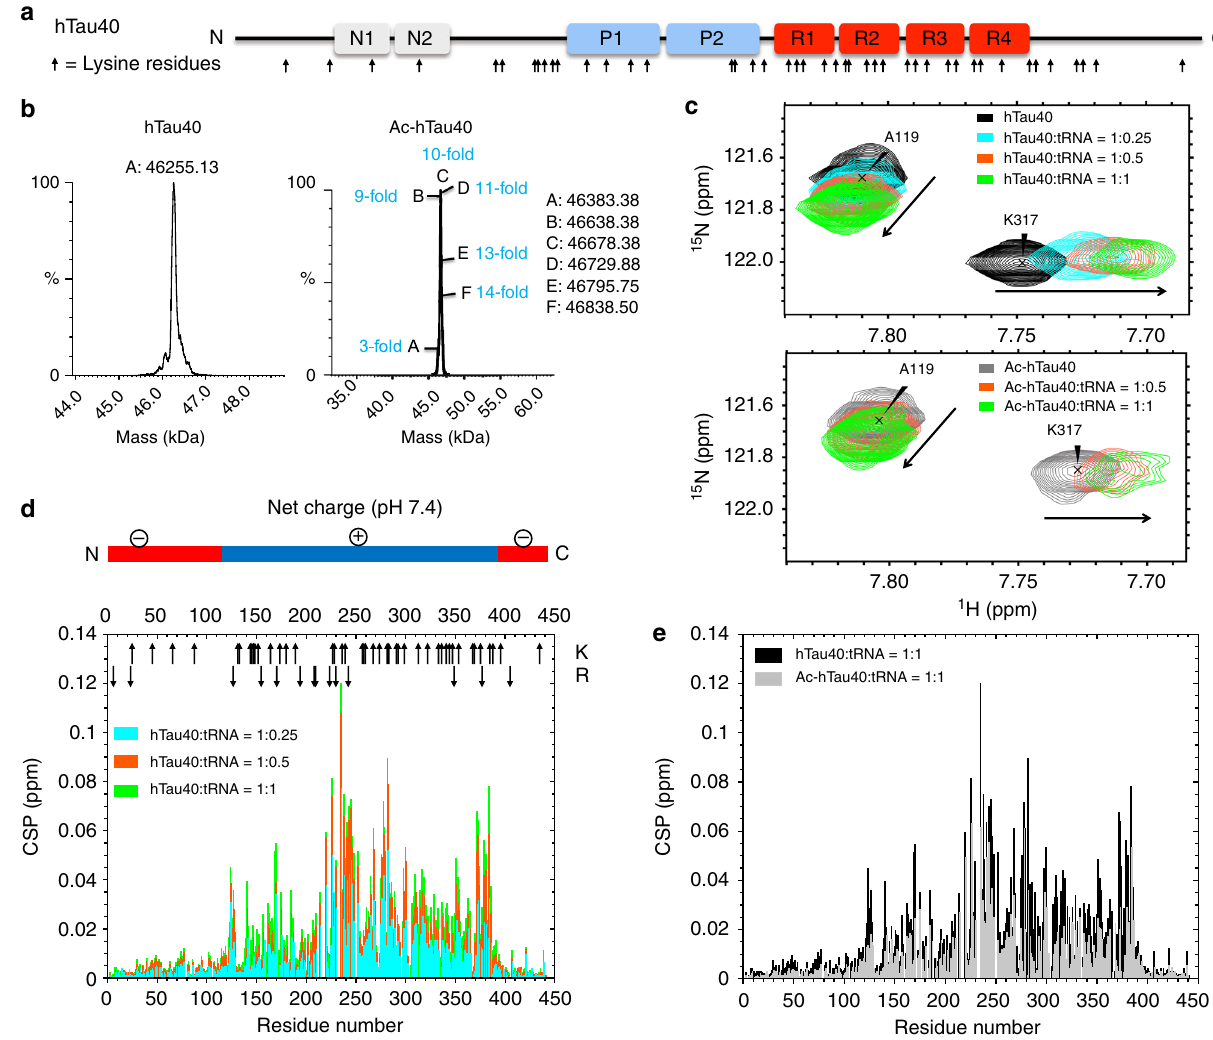
Fig. 7 Acetylation weakens binding of tau to RNA. a Domain organization of hTau40. The location of its 44 lysine residues is marked by arrows. b Mass spectra of 15 N-labeled hTau40 (left) and 15 N-labeled hTau40 acetylated by CREB (right). Identi fi ed masses (in Da) are indicated. Tau is acetylated at up to 14 sites. c Superposition of selected regions of 2D 1 H- 15 N spectra of hTau40 (top, black) and acetylated hTau40 (bottom, gray), respectively, for increasing molar ratios of tRNA: 0.25 (cyan), 0.5 (orange) and 1 (green). d Averaged 1 H, 15 N chemical shift perturbations (CSP) of resonances in 2D 1 H- 15 N HSQC spectra of hTau40 caused by binding to tRNA (color code as in c ). The net charge of different domains of hTau40 is illustrated on top. Arrows mark lysine and arginine residues. e CSP of resonances in 2D 1 H- 15 N HSQC of hTau40 (black) and acetylated hTau40 (gray) caused by the addition of an equimolar concentration of tRNA (see also b